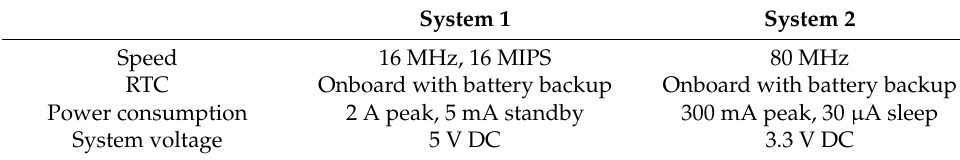
Table 1. Board comparison for microcontroller System 1 and System